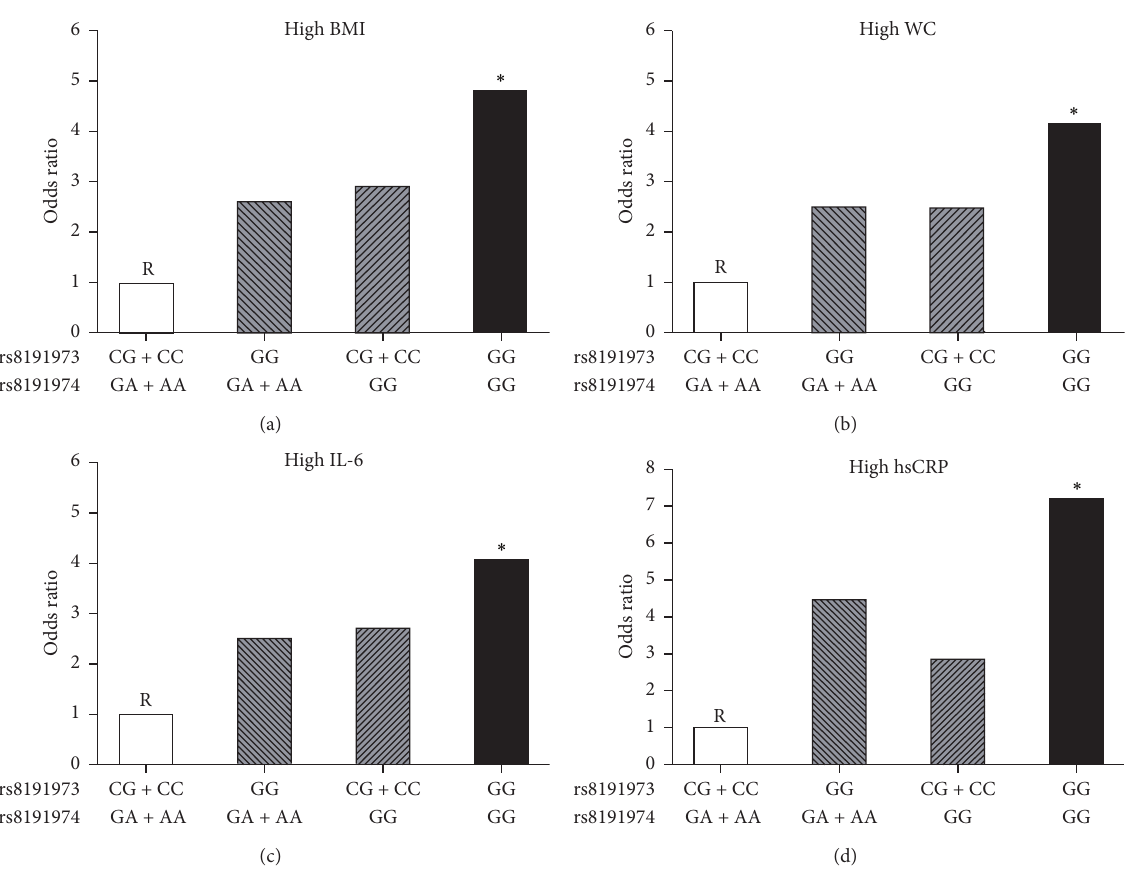
Figure1:Combinedeffectof GAS6 rs8191973andrs8191974polymorphismsontheriskofabnormalvariablesinboys. ∗ 𝑃 < 0.05 ;R=reference